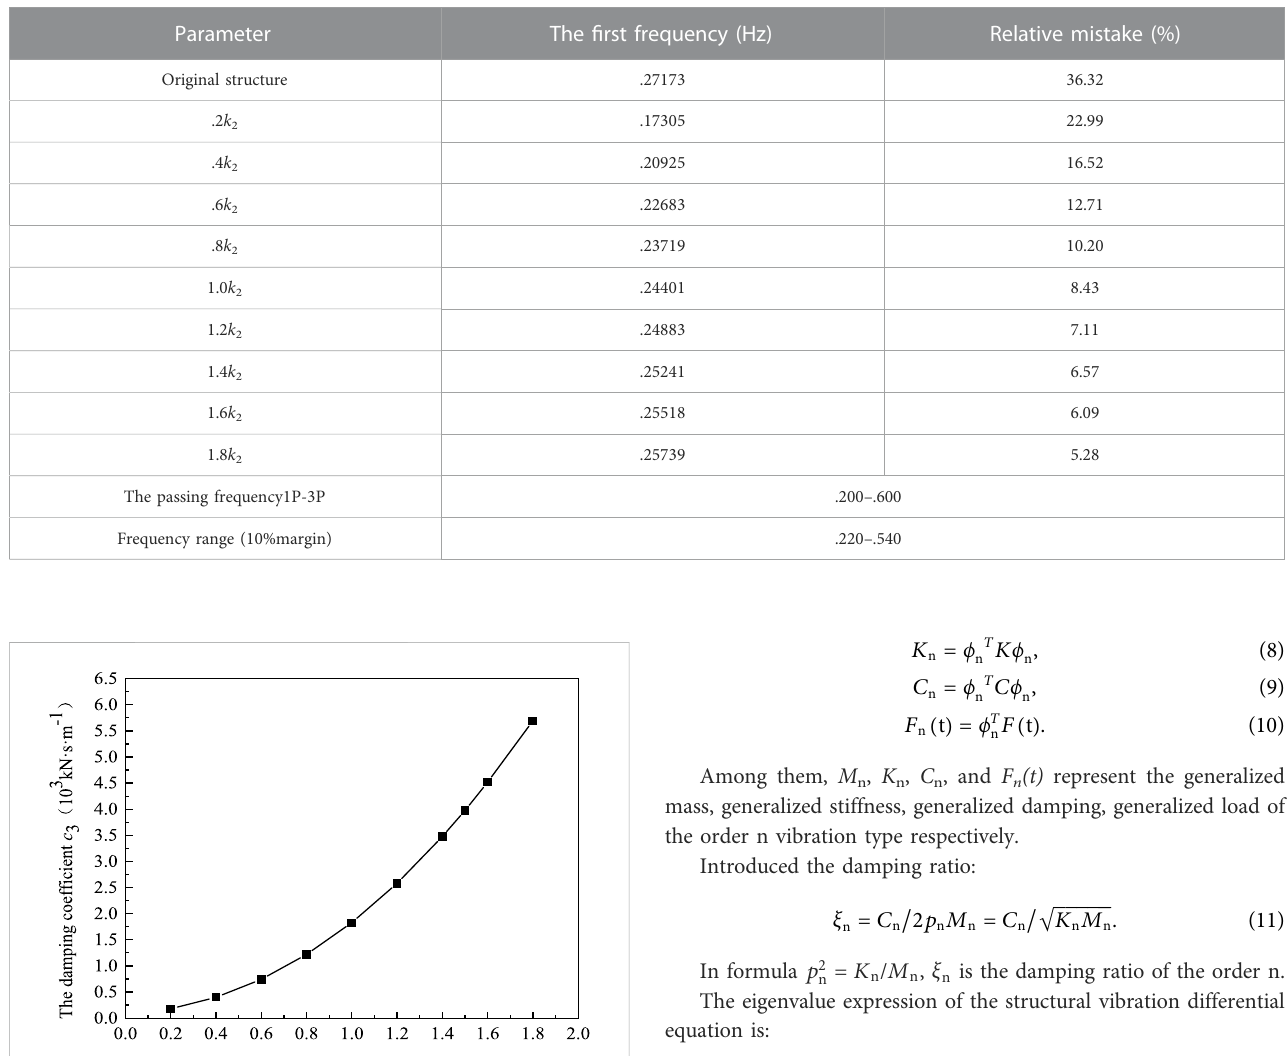
TABLE 3 The fi rst frequency of damping vibration isolation system under different stiffness coef fi cients.